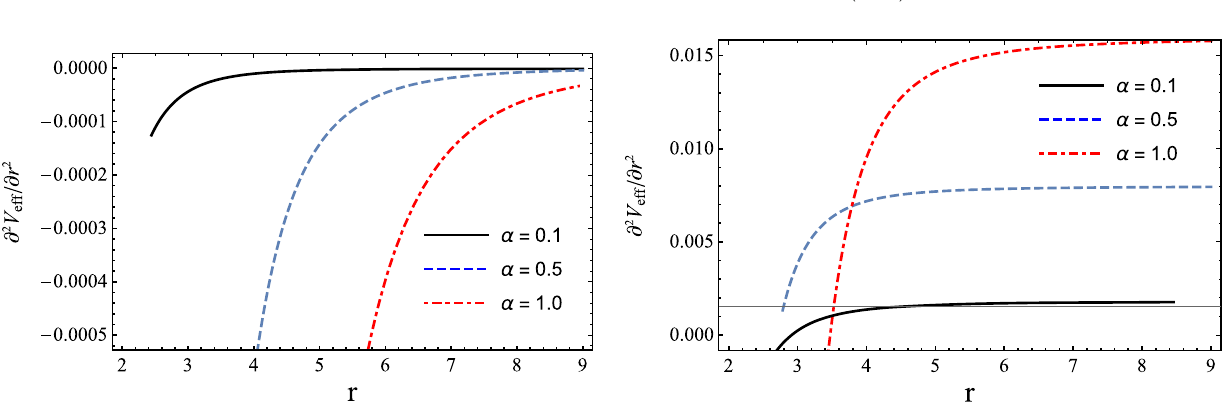
Fig. 4 The radial profile of ∂ 2 V eff /∂ r 2 for test particles making a cir- cular motion around a (2+1)-dimensional BTZ black hole in GB gravity is plotted for different values of GB parameter α . Left/right panels refer to (cid:4) = 0 / − 0 . 001, respectively. Whereas, in the case of the (2+1)-